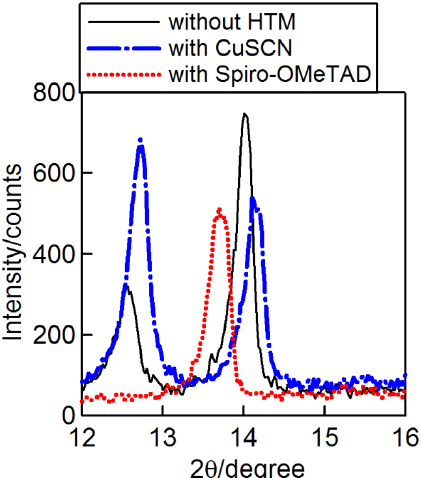
Figure 3. XRD patterns of the two-step-processed CH 3 NH 3 PbI 3 perovskite layers varied by hole-conducting materials (HTM) on the perovskite layer. 2,2’,7,7’-Tetrakis-( N,N -di- p - methoxyphenylamine)-9,9’-spirobifluorene is represented as